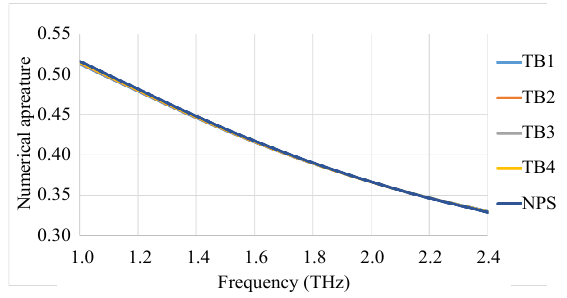
Fig. 12 NA of the proposed sensor for various tuberculosis-infected samples versus frequency.